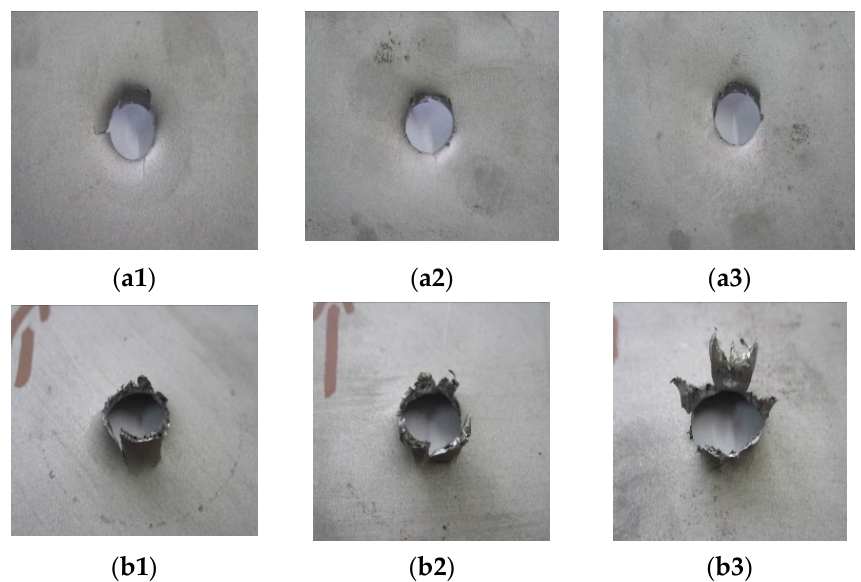
Figure 14. Results of dynamic impact tests of 1 mm Ti6Al4V sheet: ( a1 – a3 ) view from above; ( b1 – b3 ) view from bottom.